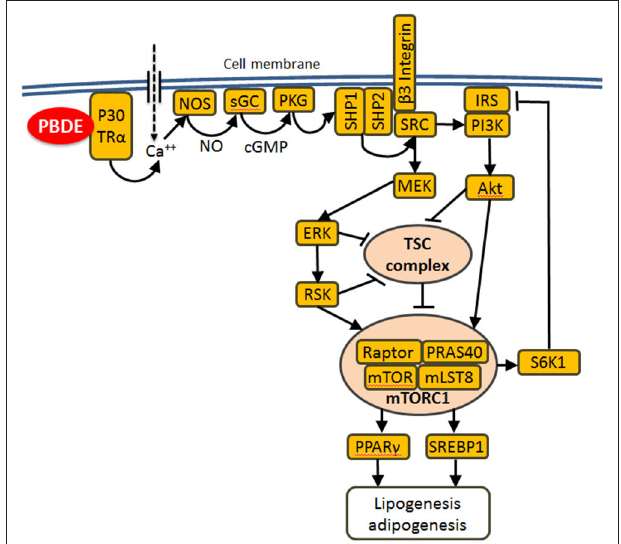
FIGURE 6 | Proposed mechanism of metabolic reprograming by PBDE: PBDEs or their metabolites bind to the plasma membrane associated p30 TR α 1 and induce an increase in intracellular Ca 2 + concentration, which leads to activation of the NO-cGMP-PKGII signaling cascade and the phosphorylation and activation of the SHP1/SHP2 phosphatase complex. This complex activates SRC which in turn activates MEK-ERK and PI3K-AKT signaling. Both cascades merge on and suppress tuberous sclerosis complex (TSC), which is a potent mTORC1 suppressor. Lipogenesis and adipogenesis are regulated by mTORC1 mainly via SREBP1/2 and PPAR γ transcription factors that control the expression of genes involved in fatty acid and cholesterol synthesis, lipid uptake and storage. Additionally mTORC1 directly phosphorylates/activates S6K1 which phosphorylates/suppresses IRS1 causing insulin